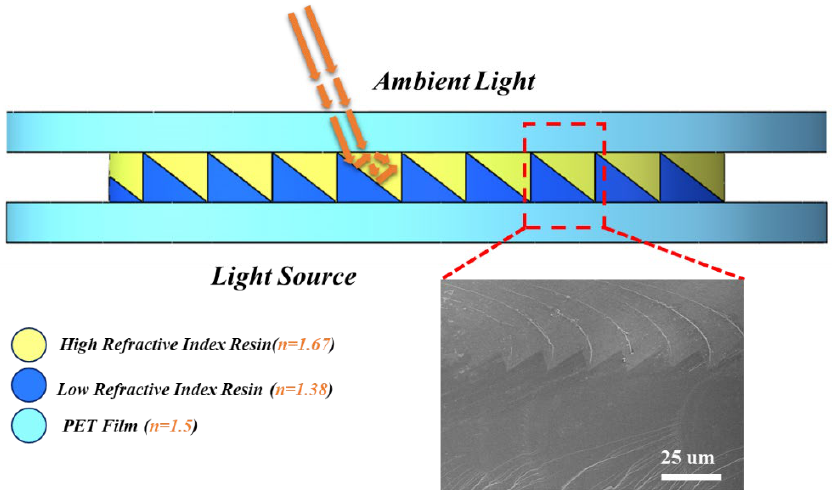
Figure 10. Demonstration of light propagation in ARCs.